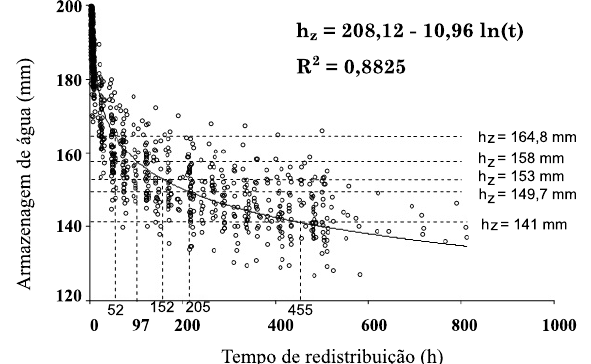
.Figura 8. Armazenagem de água ao longo do